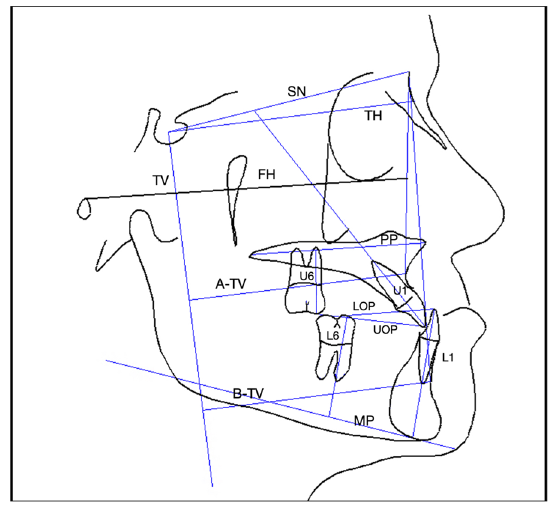
Fig. 4 Cephalometric measurements and reference lines. SN Sella-Nasion line. TH true horizontal line 7° from SN. TV true vertical line 90° from TH through Sella. A-TV perpendicular distance from A point to TV, B-TV perpendicular distance from B-Point to TV, FH Frankfort horizontal line, PP palatal plane through ANS-PNS, MP mandibular plane, UOP upper occlusal plane: maxillary incisal tip to mesiobuccal cusp of first molar, LOP lower occlusal plane: mandibular incisor tip to mesiobuccal cusp of mandibular first molar. U1 long axis of the most labial upper incisor, L1 long axis of the most labial mandibular incisor, U6 maxillary first molar long axis: mesiobuccal cusp to mesiobuccal root tip, L6 mandibular first molar long axis: mesiobuccal cusp to mesial root tip